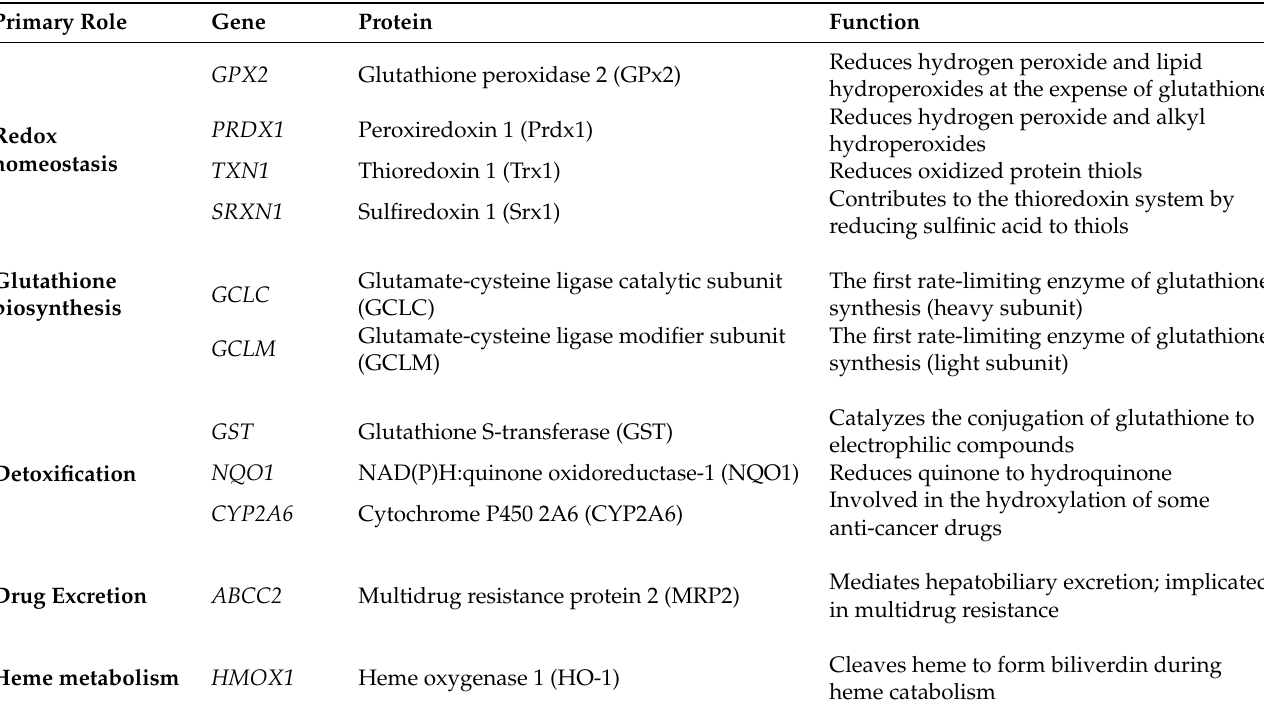
Table 3. Examples of cytoprotective genes regulated by Nrf2.